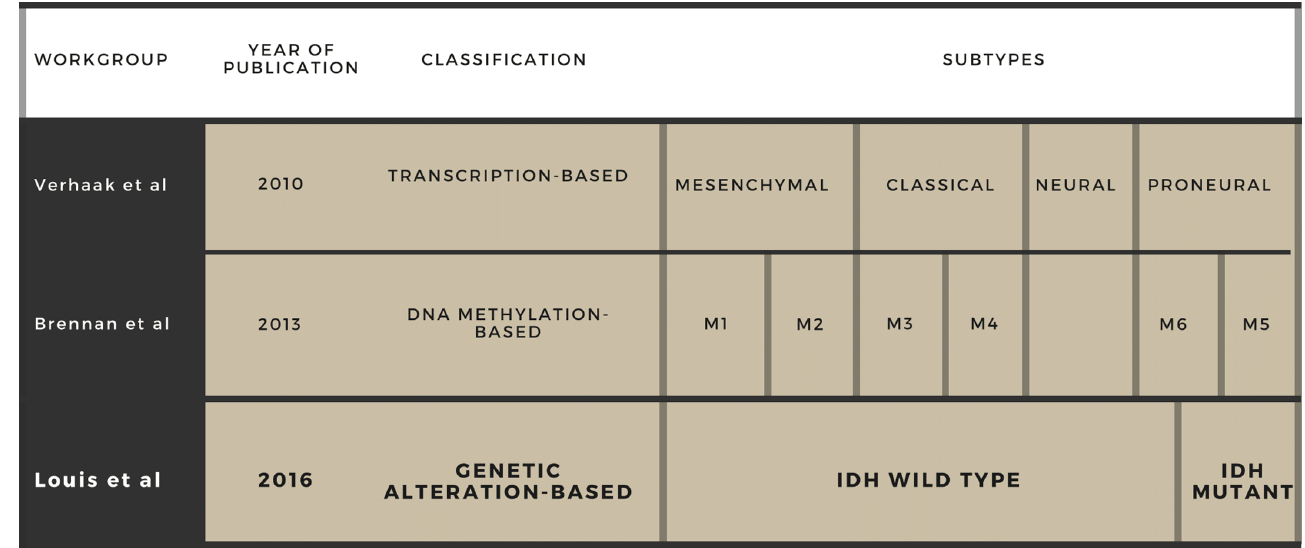
Figure 1. Molecular-based GBM classifications. Milestones in the classification of the glioblastoma subtypes (current WHO definition highlighted in bold).